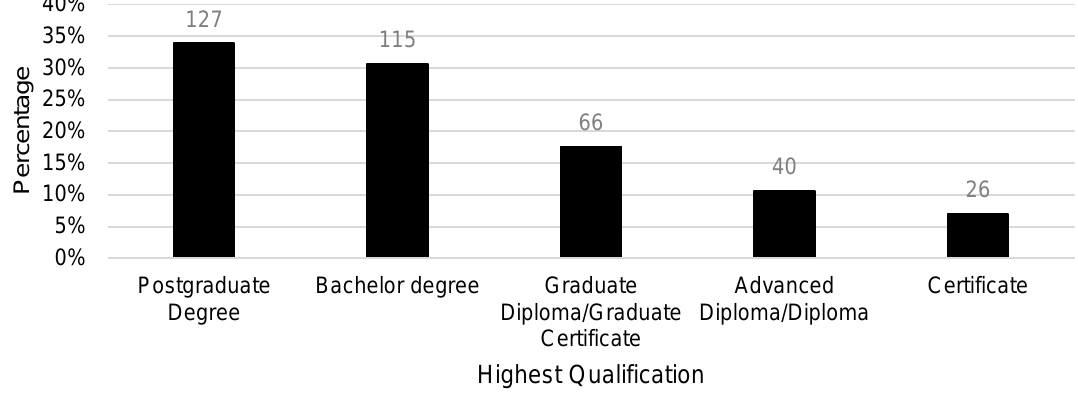
Figure 8. Highest level of qualification of participatory and deliberative practitioners (n=374). Qualification areas. While the sample was highly qualified, there are no dedicated higher education qualifications for community engagement in Australia (Christensen,